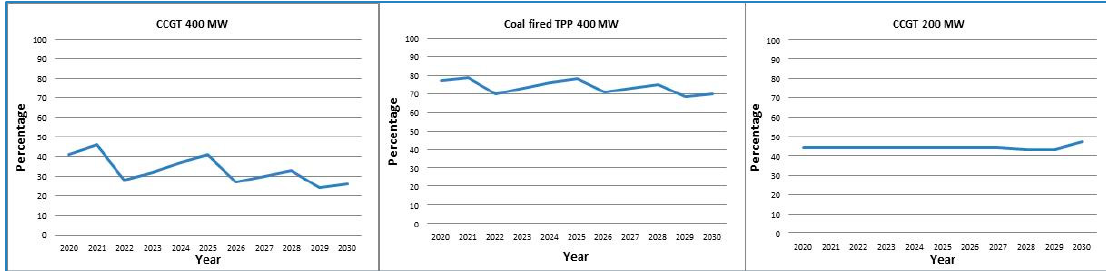
Figure 9. Load factor of new power plants in scenario with LOLP = 0.01% and VOLL $10 USD/kWh. Energies 2019 , 12 , x FOR PEER REVIEW